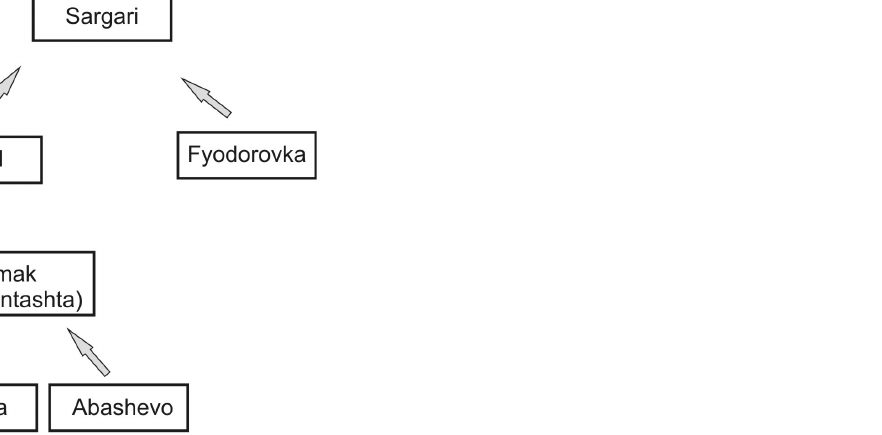
Figure 11. Scheme of cultural genesis of the Noviy Kumak type monuments with the parallel existence of Andronovo cultures (Smirnov & Kuz’mina,